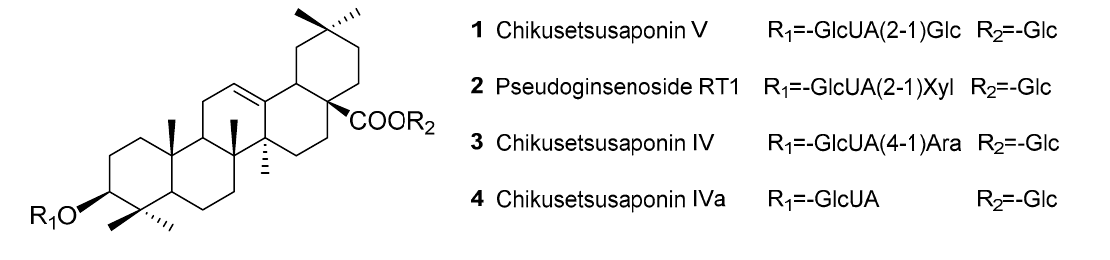
Figure 1. Chemical structures of analytes 1 – 4 .